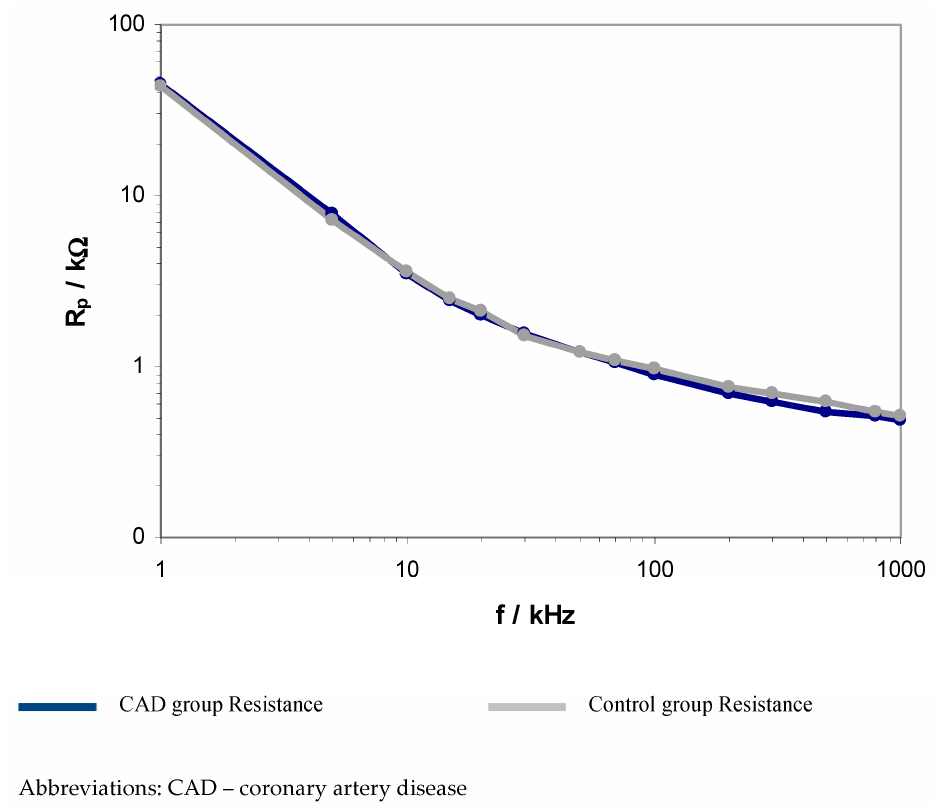
Figure 1. Logarithmic comparison of EIS resistance between CAD and control group within the range from 1 kHz to 1 MHz.